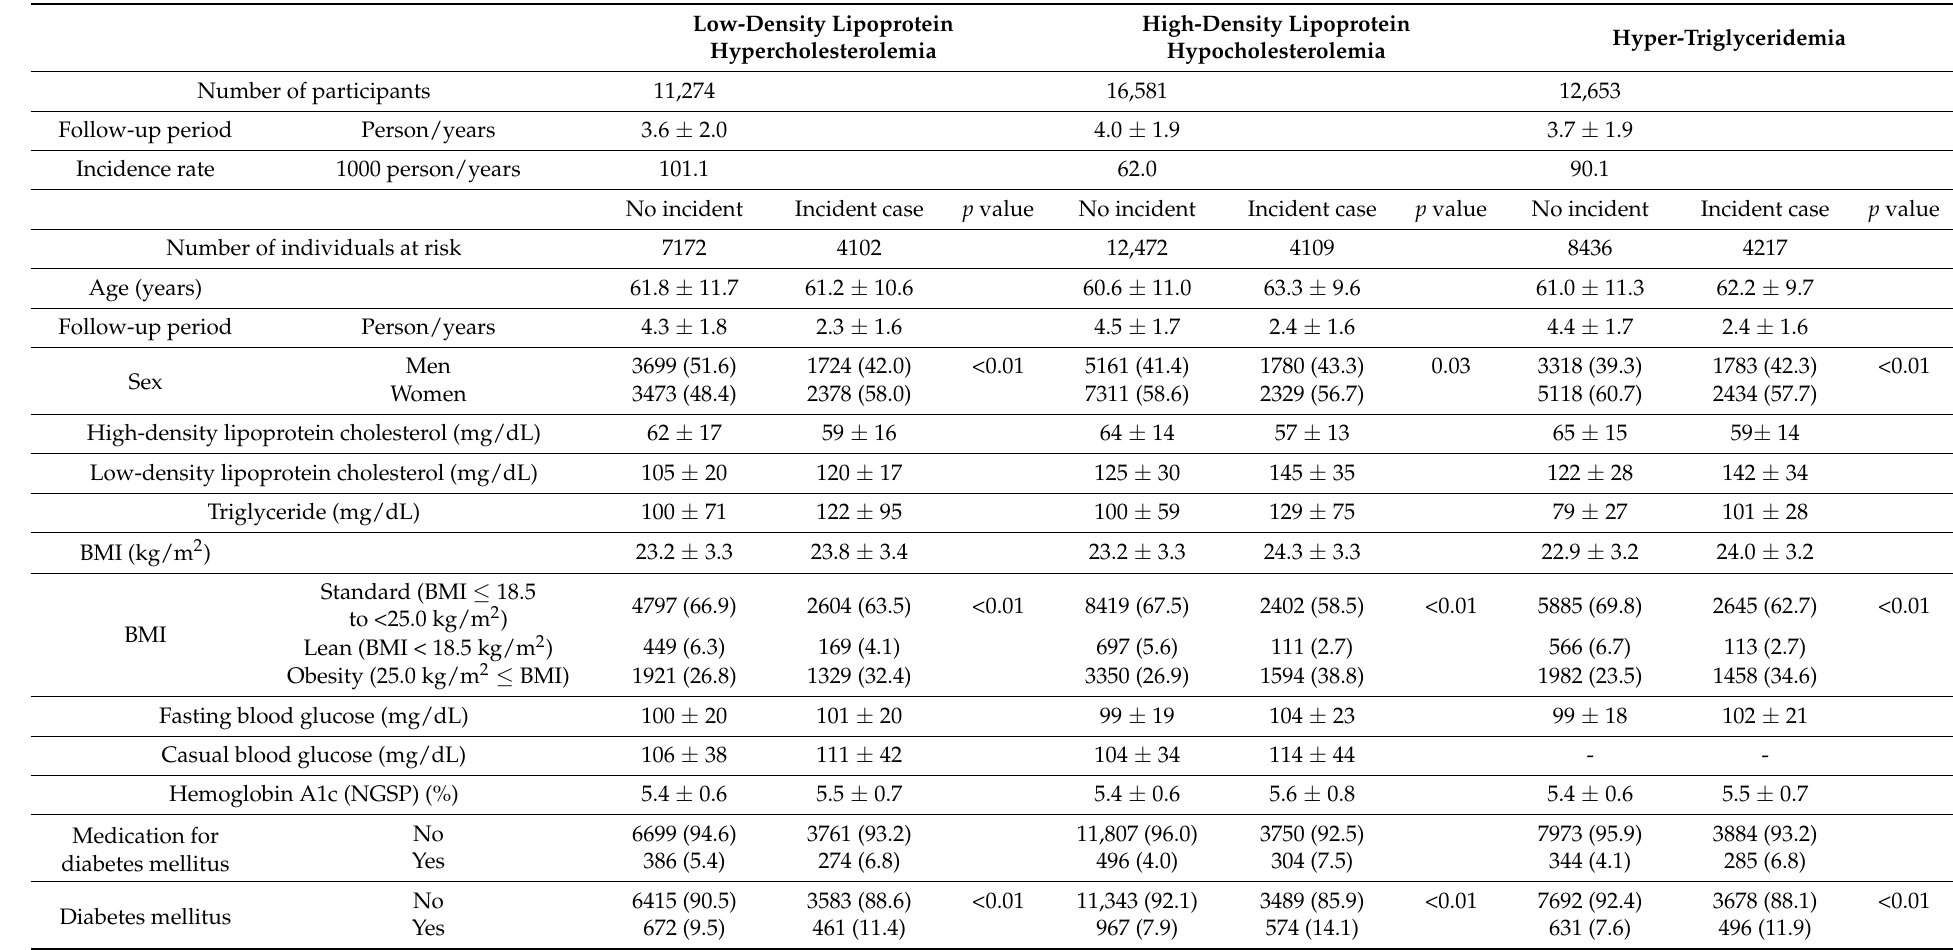
Table 1. Comparison of the physical characteristics of the